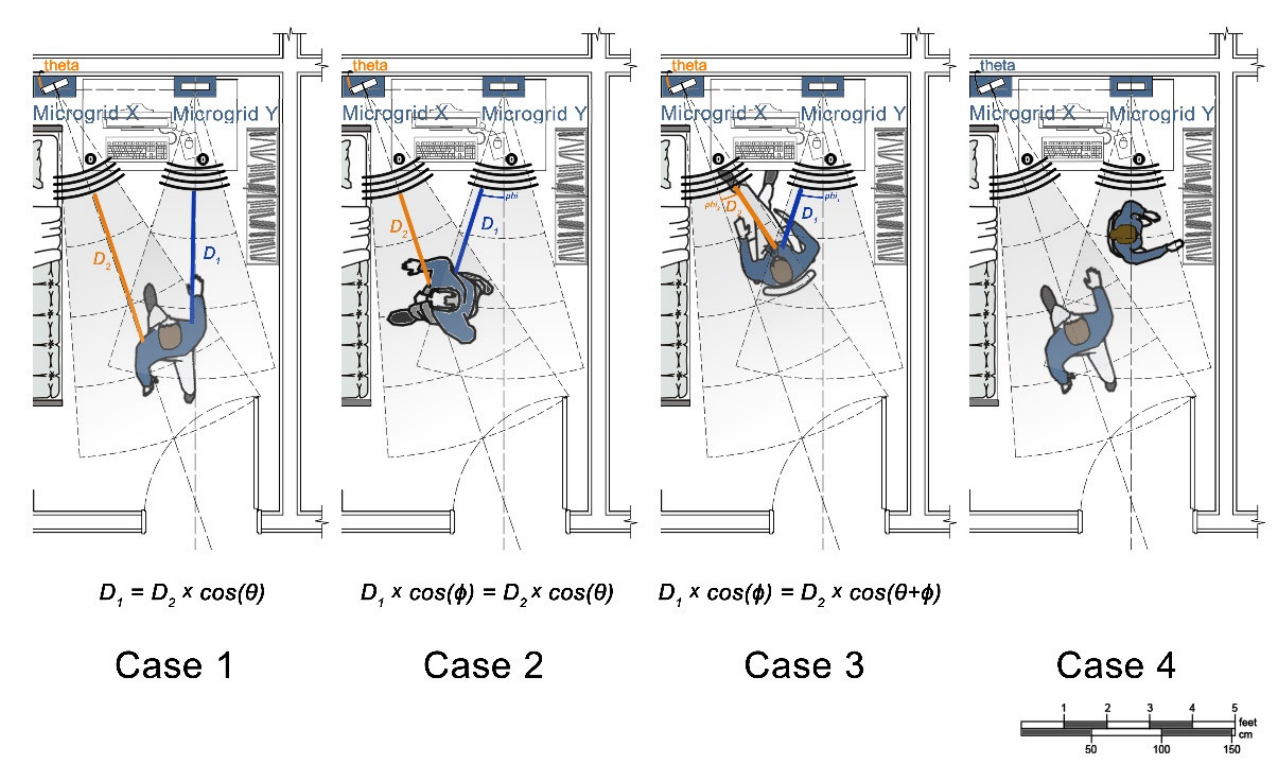
Figure 4. Evaluation of cases by spatial configuration and measurements.